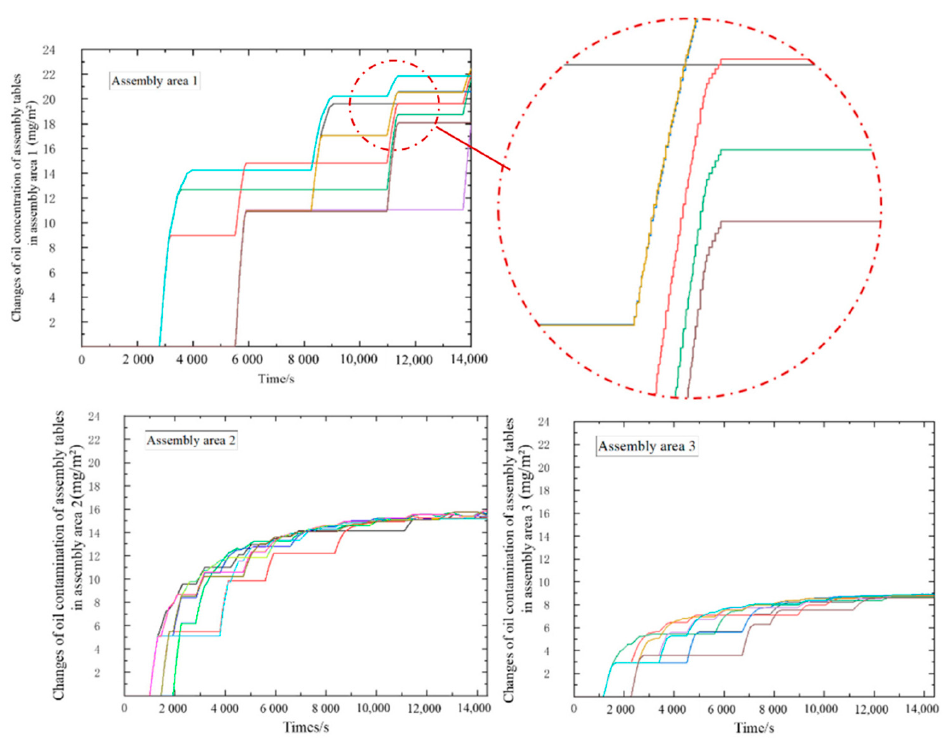
Figure 6. Changes in oil concentration on assembly tables in the three assembly areas.